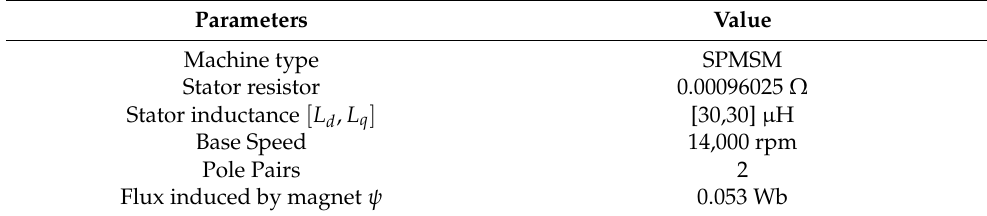
Table 1. PMSM generator